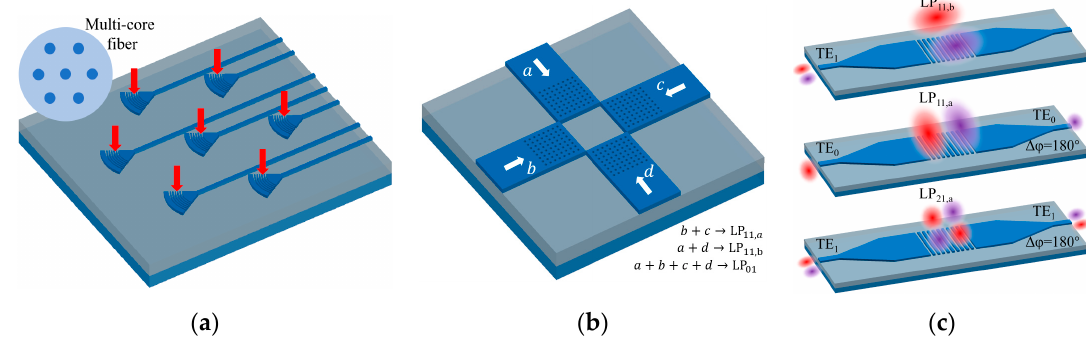
Figure 9. ( a ) Multi-core fiber (MCF) multiplexer based on multiple GCs [105]; ( b ) Few-mode-fiber mode multiplexer based on multiple GCs [114]; and ( c ) FMF mode multiplexer based on single GC [118].